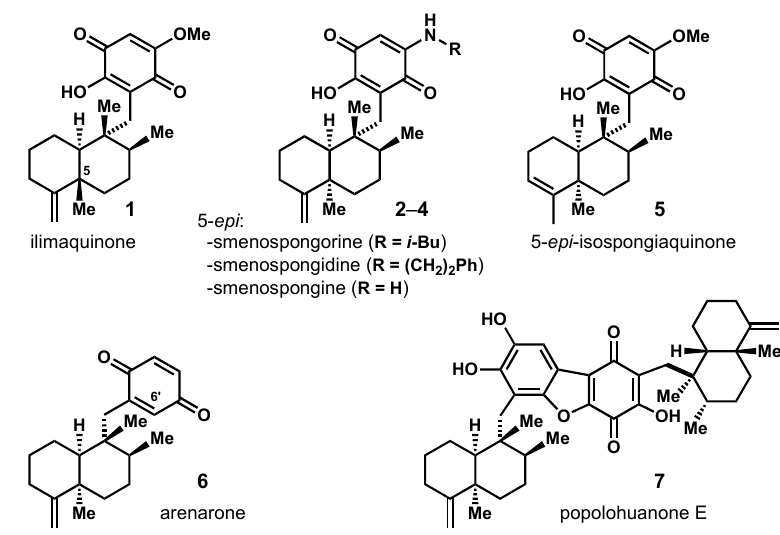
Figure 1. Bioactive cis -fused sesquiterpene quinones and their relationship to (-)-ilimaquinone. 6’-hydroxy variant is a biosynthetic precursor of the cytotoxic dimer 7 (Figure 1) [19]. Common strategies for accessing the cis ring juncture include bicyclization through intramolecular Hosomi- Sakurai reactions [18,20] and the substrate-controlled hydrogenation of ene-decalin derivatives